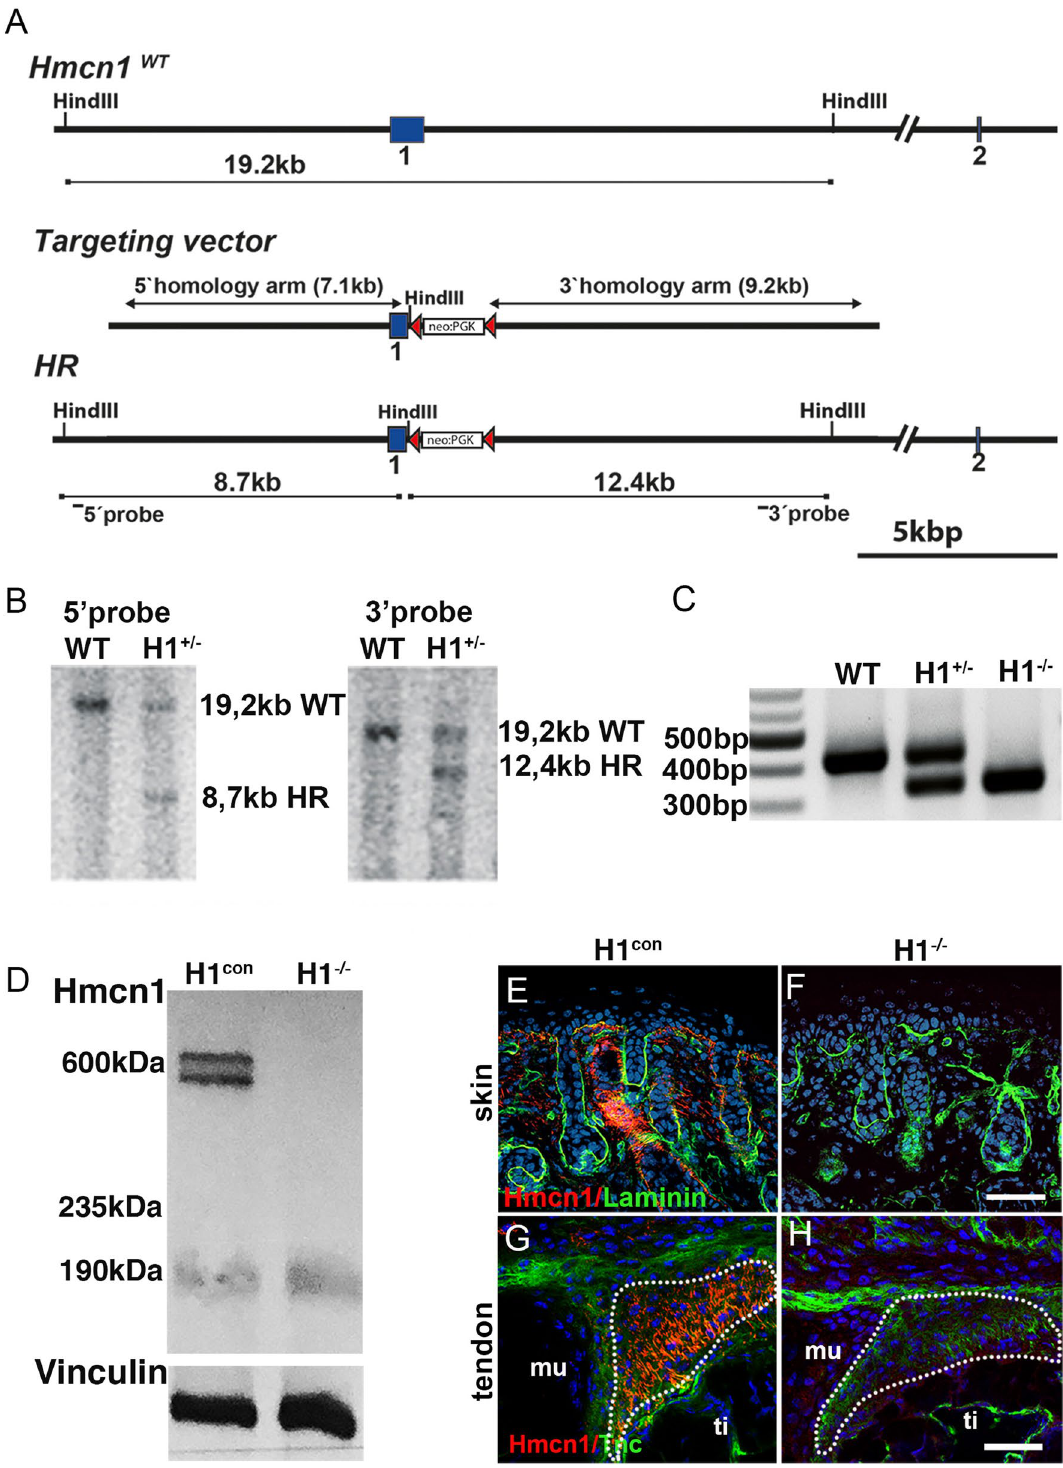
Figure 3. Generation of Hmcn1 mutants by conventional gene targeting strategy. ( A ) Diagram representing wildtype locus of the Hmcn1 gene (upper), the targeting vector used to generate the Hmcn1 knock-out allele by partially substituting exon 1 by a neomycin resistance cassette (middle) and recombined DNA after homologous recombination (lower). The frt sites are shown as red triangles. The neo-cassette was removed after crossing chimeric mice with animals carrying the Flp-e deleter allele. ( B ) Verification of Hmcn1 gene replacement by Southern blot analysis of HindIII -digested genomic DNA from ES cells using 5 ′ and 3 ′ probes demonstrated in A and by PCR analysis of mice using primers spanning exon 1 ( C ). ( D ) Western blot of skin lysates of adult mice showed the absence of Hmcn1 protein (bands at 600 kDa) in homozygous mutants. Vinculin probed on the same membrane is shown as a loading control. For full-size unprocessed images of (B-D), see Supplmental Information. ( E–H ) Confocal immunofluorescence of Hmcn1 (red) and laminin-α2 (green) in dermis ( E, F ) and tendon ( G, H ) of neonates indicates that Hmcn1 was not detected in H1 −/− mice (mu, muscle; ti, tibia). Scale bars represent 100 µm. H1 −/− , Hmcn1 −/− mutants; H1 con , sibling controls of Hmcn1 −/−